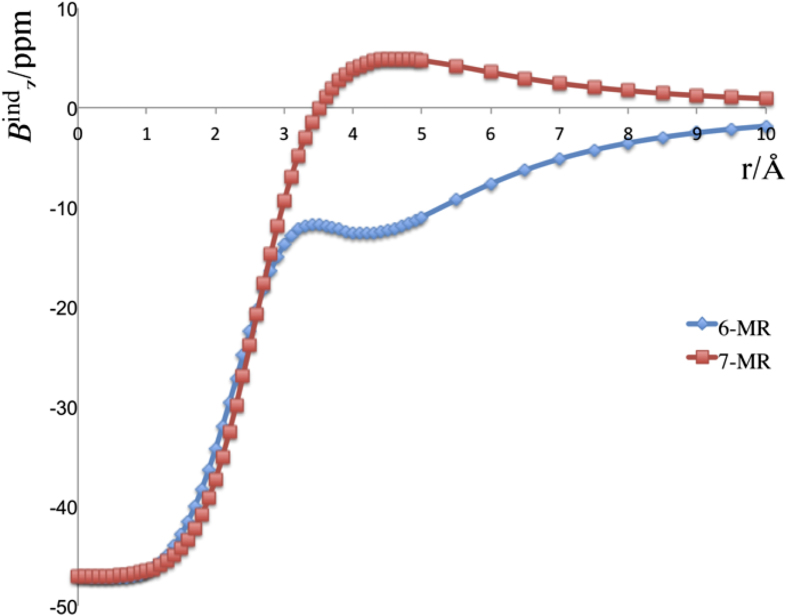
The profiles of the z-component of the induced magnetic field (Bindz) for 1.The blue (red) line shows the magnetic response computed when the external magnetic field is applied perpendicular to the 6-MR (7-MR). The scale is given in ppm (μT for |Bext| = 1 T).